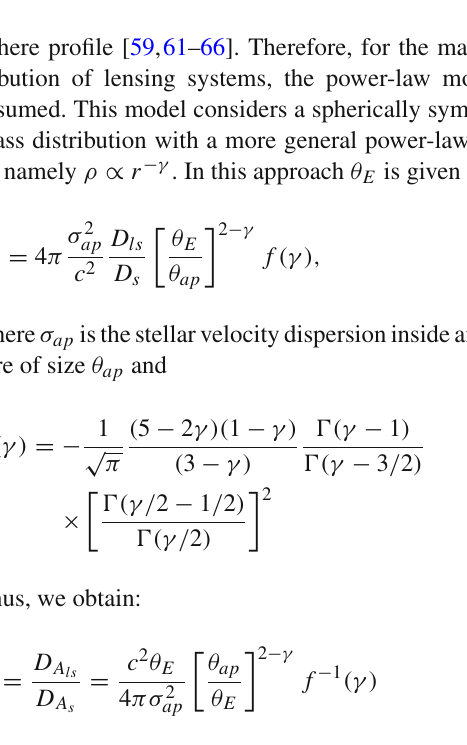
struction of the gas mass fraction at z s for the Intermediate Mass range sample using Gaussian Process Regression. The crimson shaded area indicates 1 σ and 2 σ error